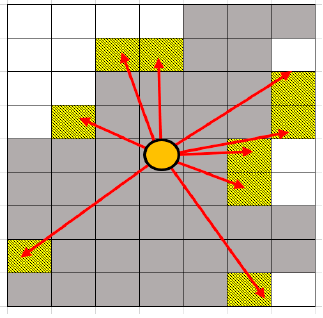
Figure 3. Miss and hit probability from a sensor scan to map pixel area.